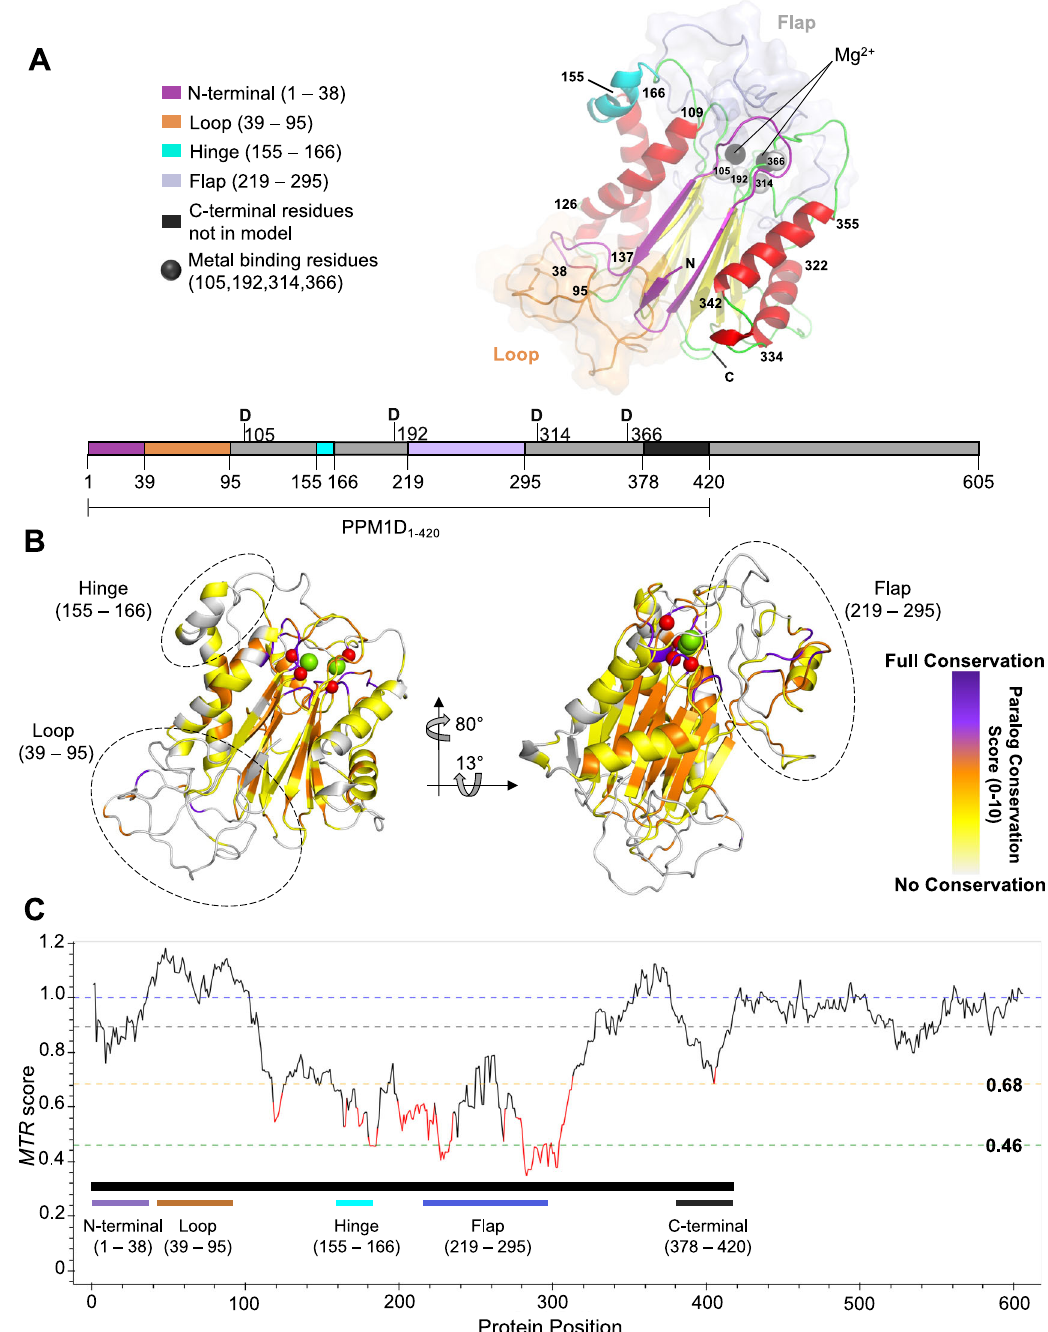
Fig. 1 Generation of a homology model and use of computational genetics to characterize PPM1D. A PPM1D homology model of residues 1 – 377 highlighting key structural regions of interest. The N-terminus (purple), loop (brown), hinge (cyan), and fl ap (light purple) are highlighted along with predicted alpha-helices (red) and beta-sheets (yellow), with the remainder of the protein in green. The loop and fl ap region are shown with an overlaying surface representation to emphasize the lack of structure predicted by the model. The metal-binding residues and metal cations are highlighted as spheres in black and white, respectively. A 2D representation is shown below the homology model. B PPM1D paralog values superimposed on the homology model. For each residue, the degree of identity across the human PPM1D paralogs was assessed and scored from 0 to 10 (purple represents full conservation, white represent no conservation). C Representation of genetic constraint in the human germline at each residue as calculate by the missense tolerance ratio. A ratio of less than 0.68 and 0.46 are in the bottom 25% and 5% of scores across the protein, next-generation sequencing. For each variant we calculated the average of the log-fold change of representation in the GFP-low (retained PPM1D activity) and GFP-high (impaired PPM1D activity) populations (Fig. 2C, Supplementary Fig. 1B, C, Source data fi le: Saturation Mutagenesis Results) 25 .